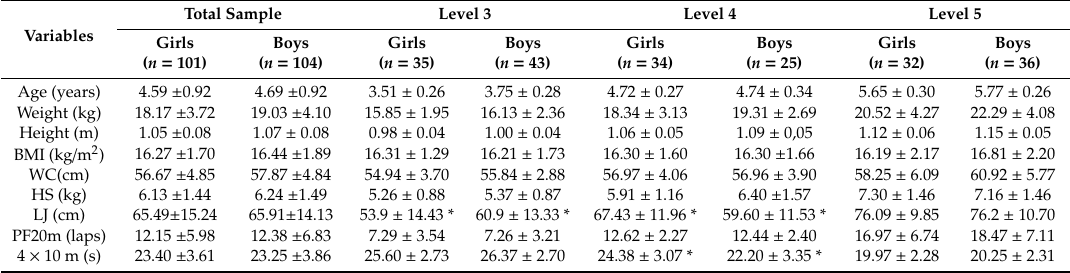
Table 2. Mean di ff erences of PREFIT physical fitness tests divided by level of preschool and sex.